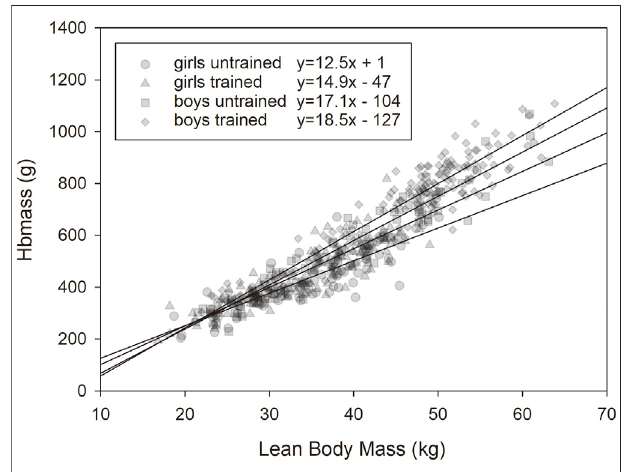
FIGURE 2 | Relationship between Hbmass and VO 2 max normalized to LBM presented for the trained (y = 2.3x + 31.0, r = 0.54, p < 0.001) and untrained groups (y = 1.4x + 30.4, r = 0.31, p < 0.01).